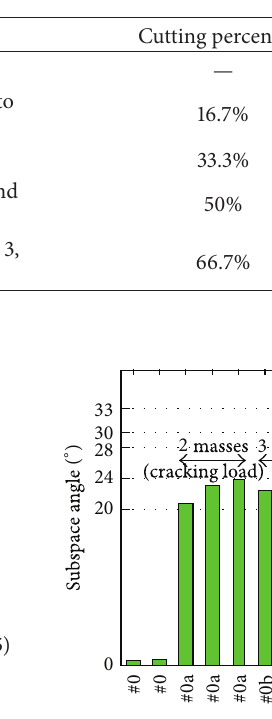
Figure 6: Panel structure and experiment schema. Table 3: Damage scenarios.